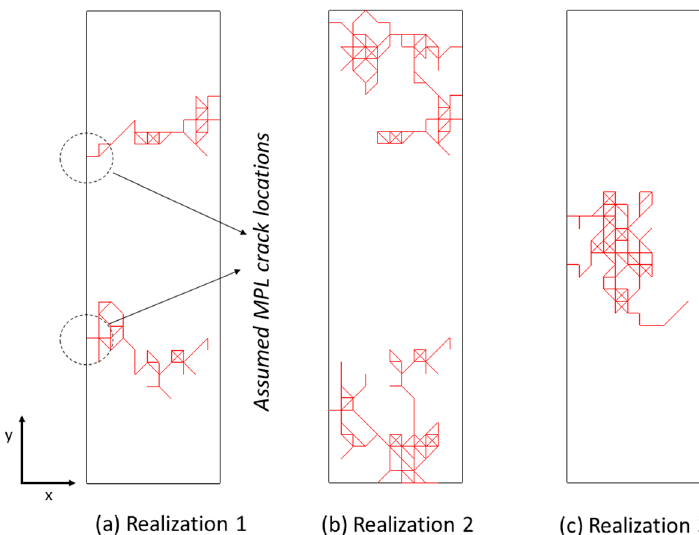
Figure 4. Liquid water pathways (denoted by read lines) in the GDL under three realizations of the crack locations at the MPL-GDL interface. There are two assumed crack locations at the ML-GDL interface. The MPL was not modeled. ( a ) Realization 1; ( b ) Realization 2; ( c ) Realization 3.